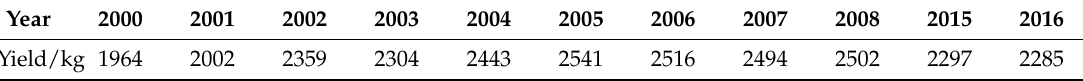
Table 1. Yields of ramie fiber of 2000–2016 with missed data of 2009–2014 in Hunan